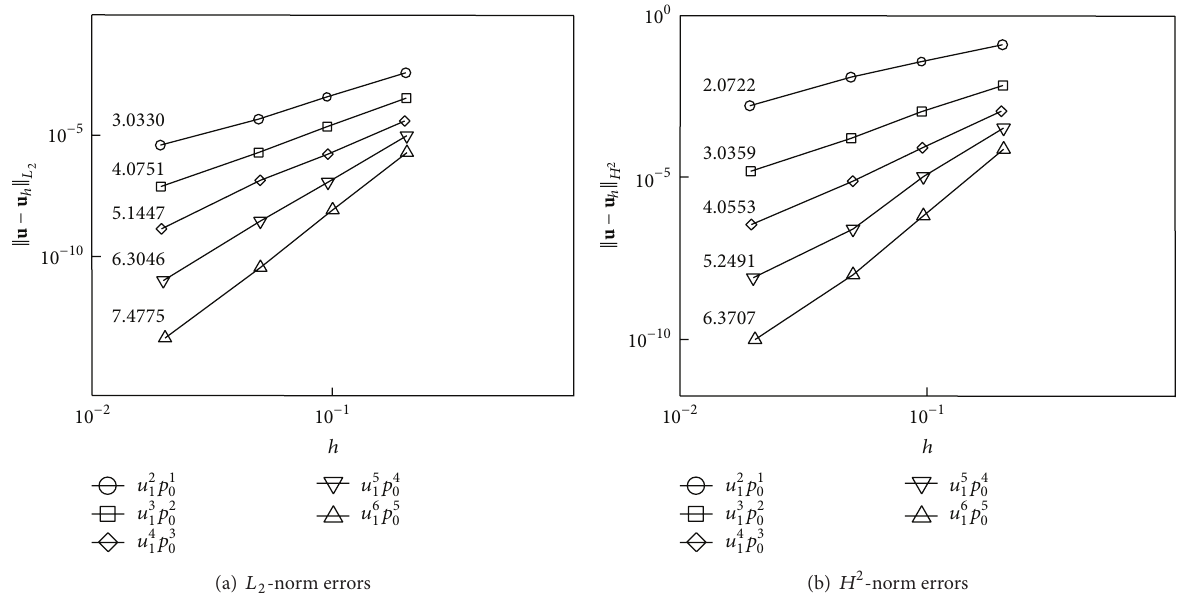
Figure 4: Convergence rate of velocity of Section 5.1.